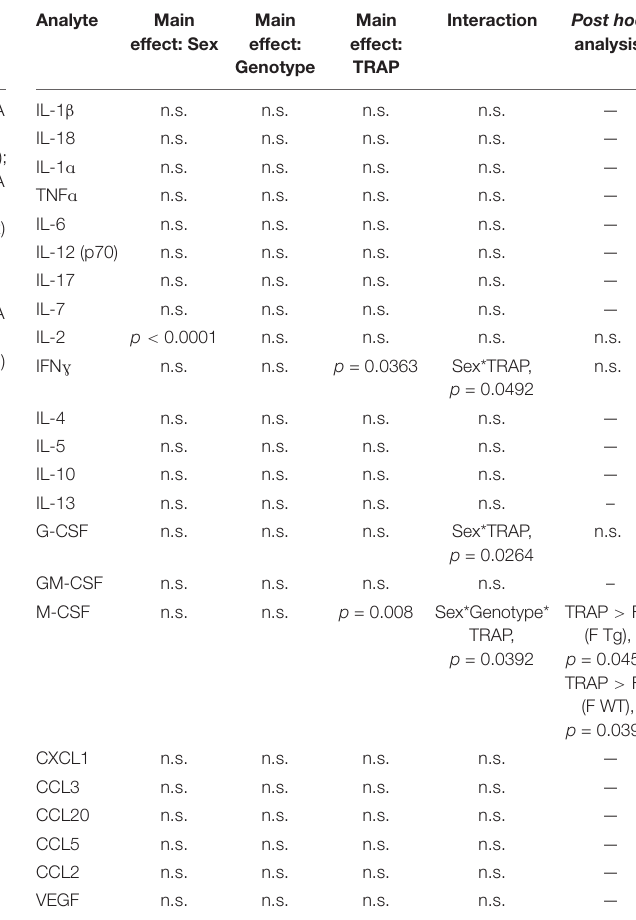
TABLE 1 | Summary of statistical comparisons for levels of cytokines, chemokines, and growth factors in the hippocampus of 3-month old TgF344-AD and WT rats after 2 months of exposure.